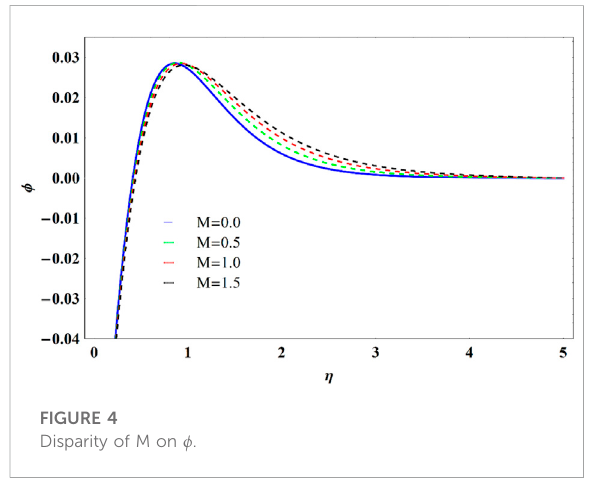
FIGURE 7 Disparity of K on ϕ